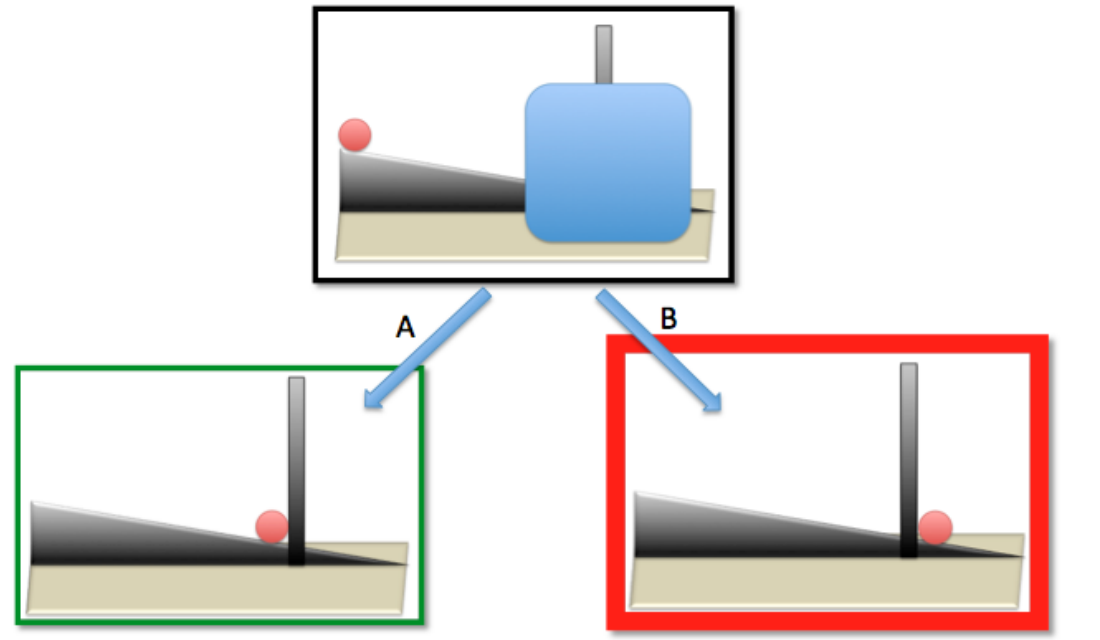
Figure 1. Common paradigm testing infants’ understanding of object solidity. After the ball is rolled down the ramp, the screen is moved to reveal either scenario A or B. Scenario A is consistent with the property of object solidity; however, scenario B violates the property of solidity. Infants stare longer at the incongruent event as discussed by Stahl and Feigensen (2015). Stahl and Feigenson (2015) further expanded on the VOE paradigm by providing the subjects with two objects: one that the infants had just witnessed violates an object property and one that the infants had just witnessed perform the same action without violating an object property. The infants played more with the object that had just behaved incongruently and even performed actions with that object to test the object property that was violated in the incongruent event. The infants were also faster to learn a new property of the object, such as that the object made noise, if they had previously seen the object behave incongruently. This study demonstrates that showing infants an event in which their expectations are violated stimulates curiosity and paves the way for hypothesis testing and learning. This finding matches Piaget’s (1952) “moderately discrepant event” in which learning is driven by events that contain both familiar and unfamiliar